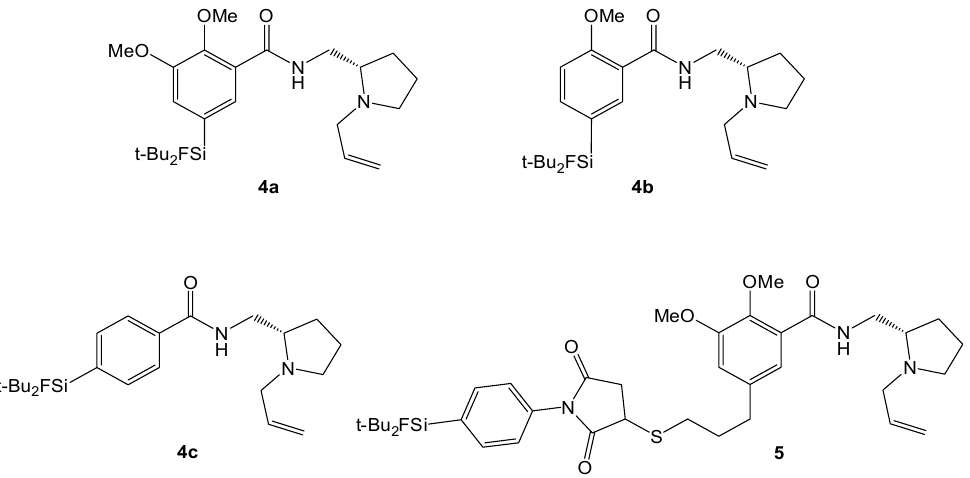
Figure 2. Synthesized SiFA-conjugated Fallypride-derivatives 4a–c , 5